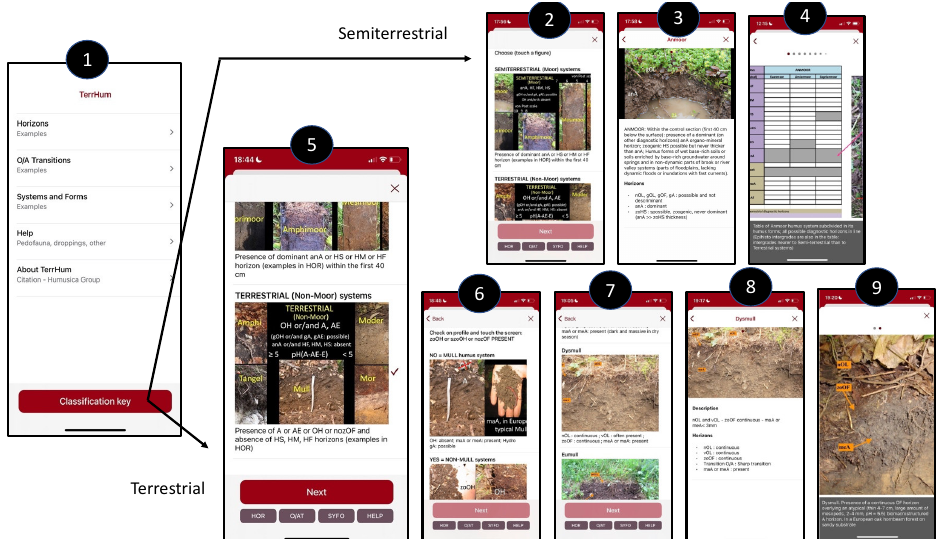
Figure 5. TerrHum is the result of a collective work and allows us to classify Terrestrial and Histic systems and forms. Indications are provided to also consider the Hydro transitions between Terres- trial and Histic, and also the complexifications of Terrestrial systems with Bryo, Ligno, and Rhizo systems. (1) Starting screen, iOS version (similar to the Android one). By clicking on the red button ‘Classification key’, the screen on the right opens; observing the profile to be classified, the user must choose between Semiterrestrial (2) and Terrestrial systems (5). To achieve this, they must search for the diagnostic horizons indicated on the screen. For example, to belong to the Semiterrestrial systems (2), a profile must show at least one of the following horizons: anA, HF, HM, HS; to belong to the Terrestrial systems (5), the profile must show OH, A, or AE horizons. If the user is a beginner, they can see photographic examples by tapping at the bottom of the screen (the four small brown rectangles at the bottom of screens 2, 5, 6, 7): HOR = diagnostic horizons, O/A T = O/A transitions; SYFO = systems and forms; HELP = tables, diagrams, other. These same commands correspond to the ones of the starting screen (1). Semiterrestrial example: By touching the screen at the “Semiterrestrial” level (2); ´ Next ´ appears in red, which allows one to move forward and scroll among examples of